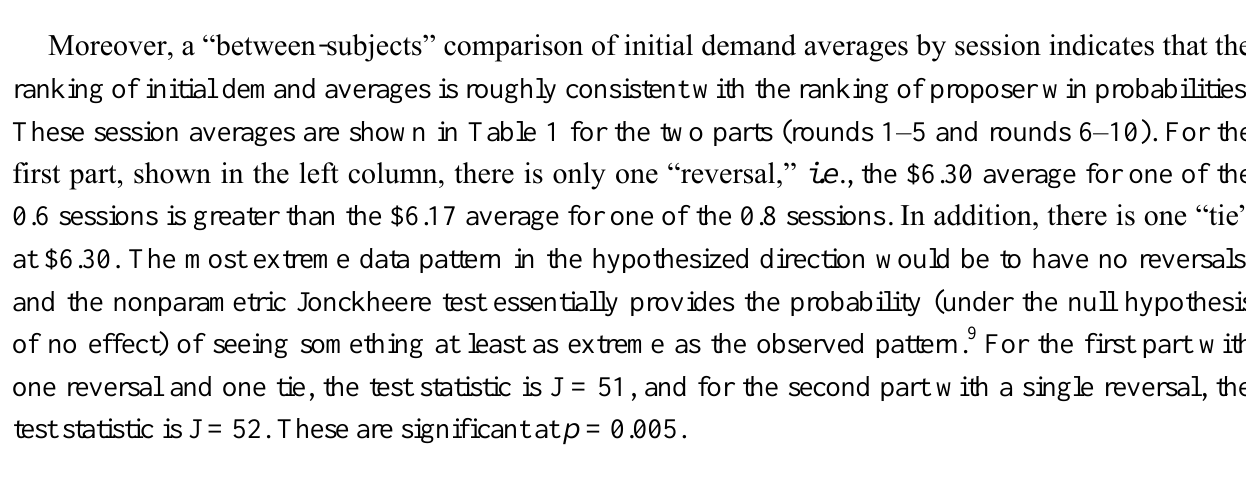
Table 1. Average Proposer Initial Demands by Session.